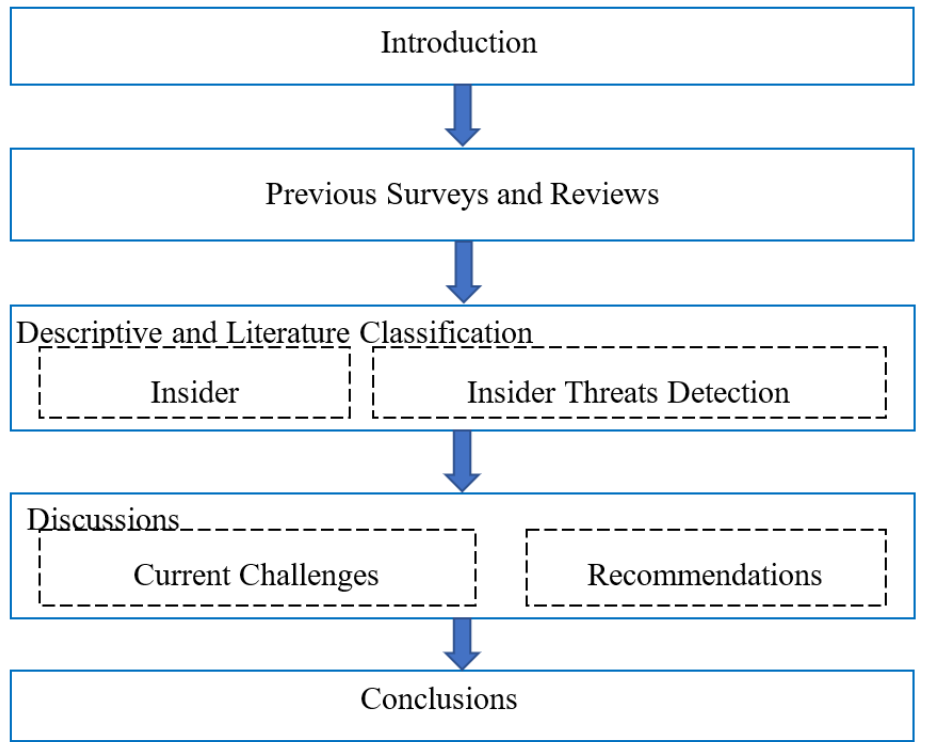
Figure 1. Article outline.